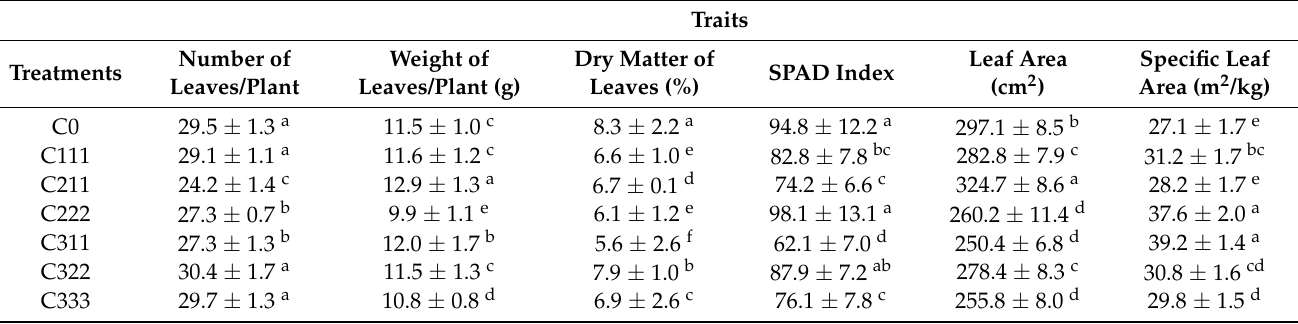
Table 1. The effect of fertilization regimes on the number and weight (g) of leaves per plant, the dry matter content of leaves (%), the chlorophyll content of leaves (SPAD index), the leaf area (m 2 ), and specific leaf area (m 2 /kg) of C. spinosum plants.